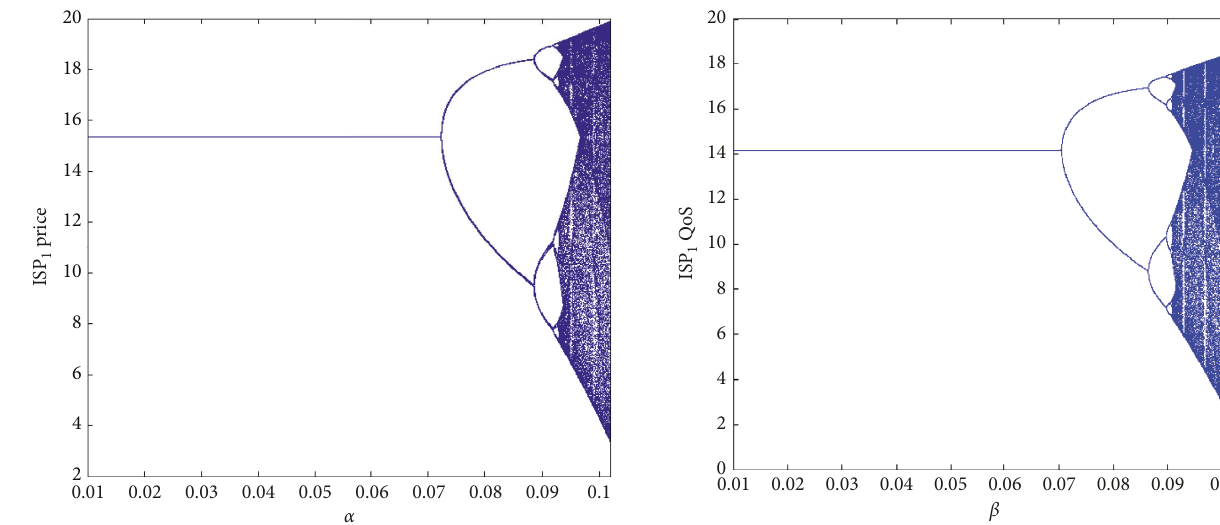
with respect to β . 1